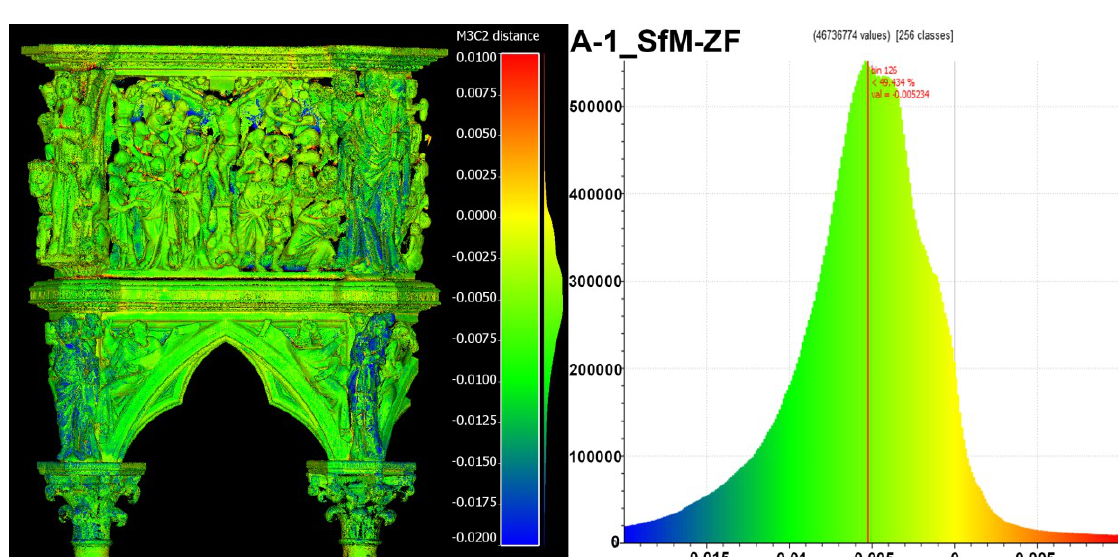
Figure 7 . SfM - ZF comparison and